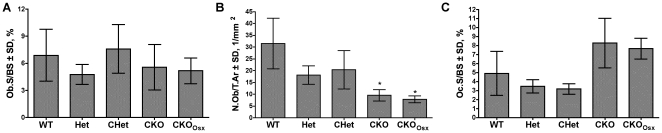
Osteoblast number is decreased in Hdac3-CKO mice.Distal femurs from 5.5 week-old male mice were sectioned and stained with Goldner's Trichrome (A and B) or TRAP (C). Osteoblast surface as a proportion of bone surface (Ob.S/BS; A), osteoblast number per tissue area (N.Ob/T.Ar; B) and osteoclast surface per bone surface (Oc.S/BS; C) were measured with Osteometrics software. n = 6−7, *p<0.05.